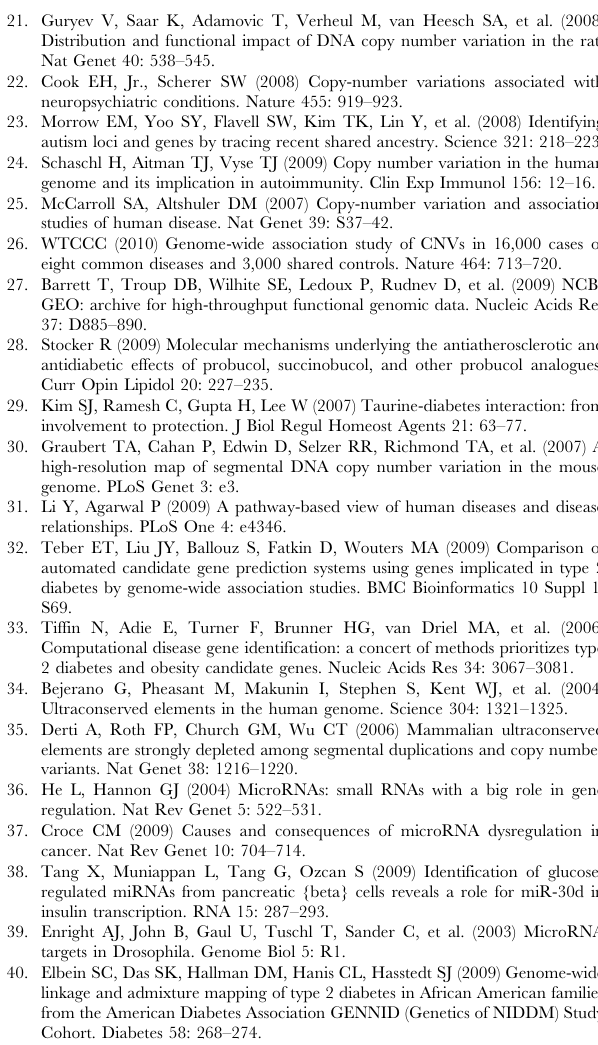
Table S9 Logarithm (base 2) ratios of CNVRs (GK vs. Wistar) containing microRNAs.